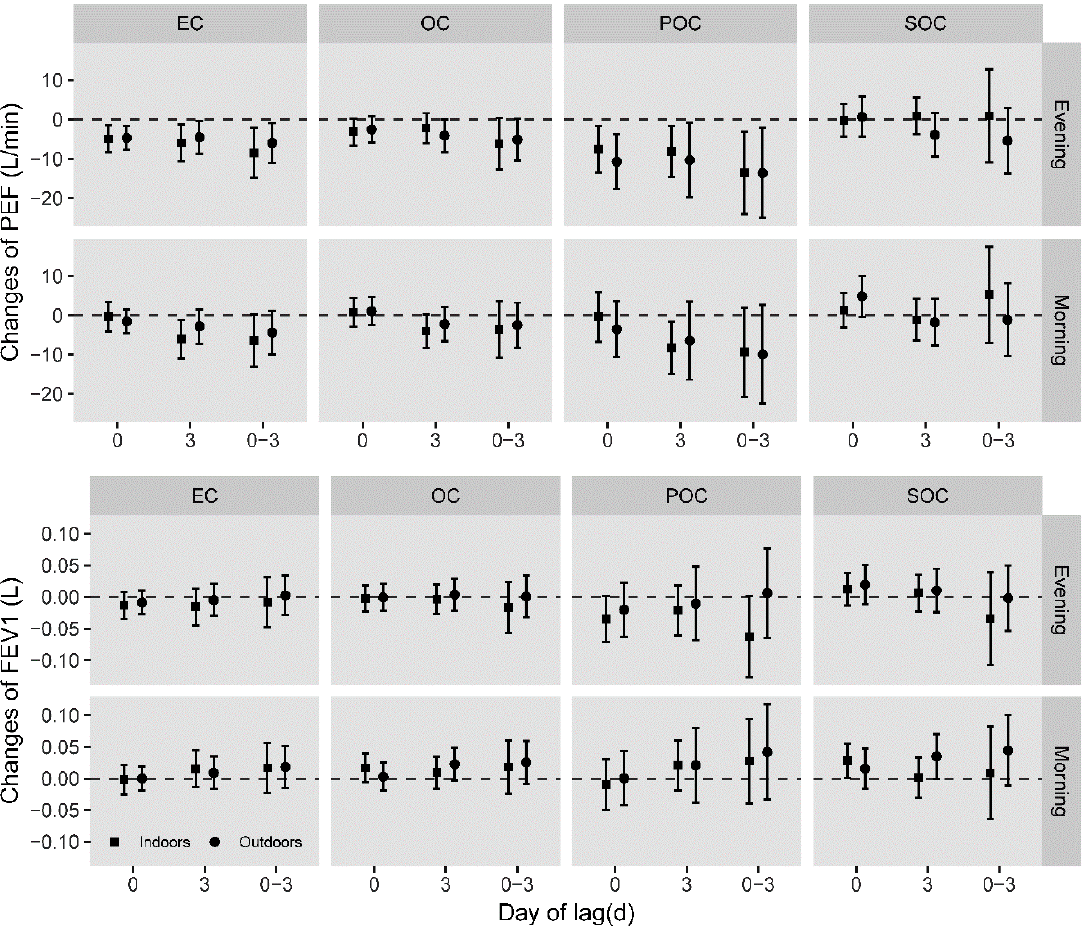
Figure 2. Estimated changes of morning/evening PEF and FEV 1 associated with 10 μ g/m 3 increase of carbonaceous compositions indoors in constituent-PM 2.5 model adjusting for total PM 2.5 mass, gender, age, height, season when the measurement was conducted, day of week, day of season, and meteorology. Squares indicate the effects of indoor compositions while circles indicate that of outdoor compositions.